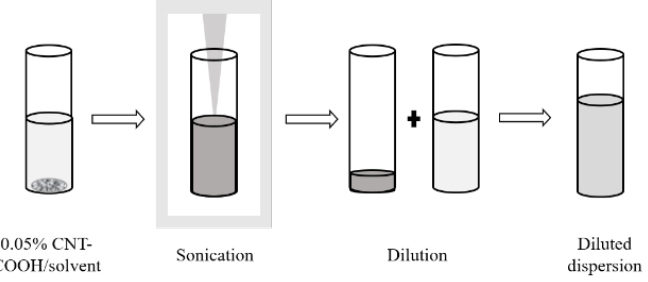
Figure 2. fMWCNT dispersion